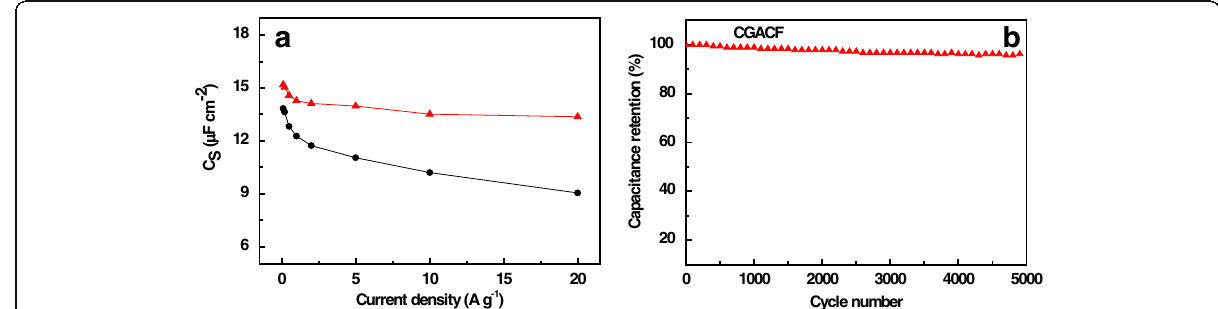
Fig. 7 C S and cycling stability tests. a C S at different current densities and ( b ) cycling stability at the current density of 1 A g − 1 for 5000 cycles of the samples. CGACF: red line and symbol ; AC: black line and